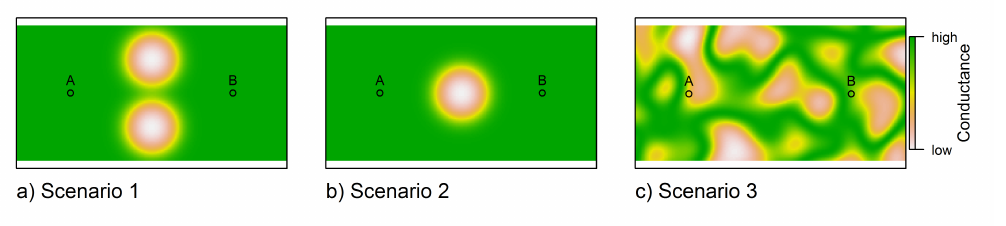
Figure 1: Three scenarios used to test field-based time geographic model; a) corridor, b) circular barrier, c) heterogeneous